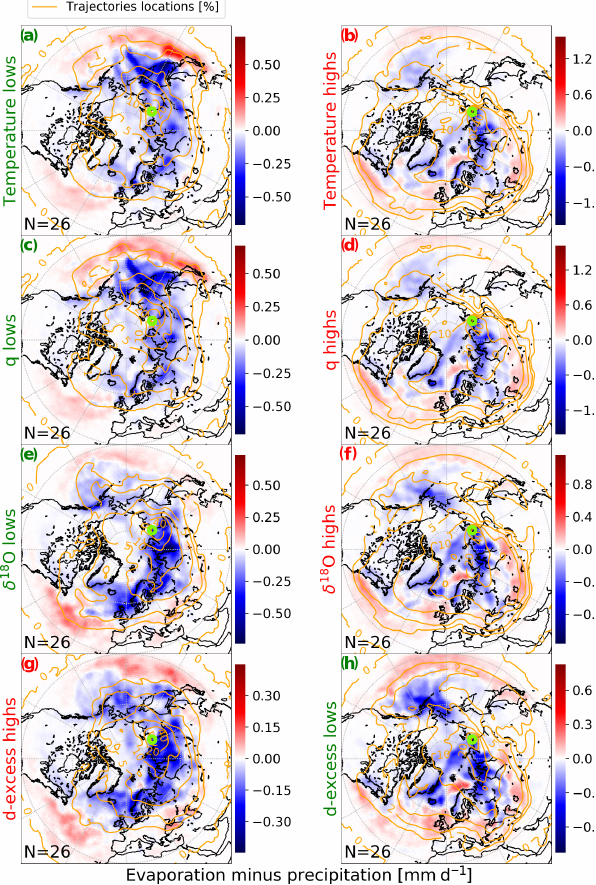
Figure 10. Average “evaporation minus precipitation” (North Pole Lambert azimuthal projection) for the selection of low and high ex- trema over the December to April period, as depicted in Fig. 9, for temperature lows (a) and highs (b) , specific humidity lows (c) and highs (d) , δ 18 O v lows (e) and highs (f) , and d -excess v highs (g) and lows (h) . The orange contour lines indicate the trajectory locations (as percentage of maximum value: 80%, 40%, 20%, 10%, 5%, 2%, 1% and 0%). The green circles indicate the location of the Samoylov